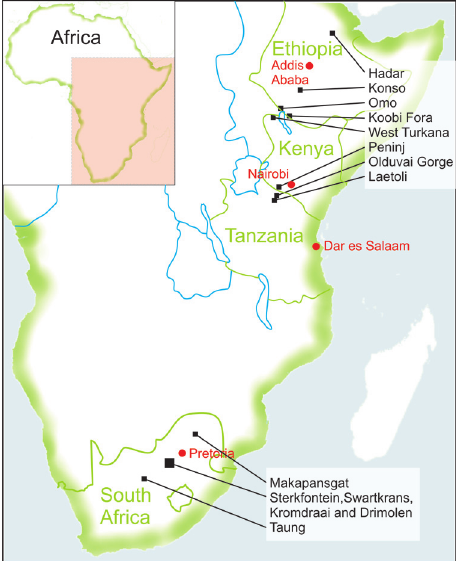
Fig. 1: Map of the major fossil sites where specimens of Australopithecus and Paran- thropus have been